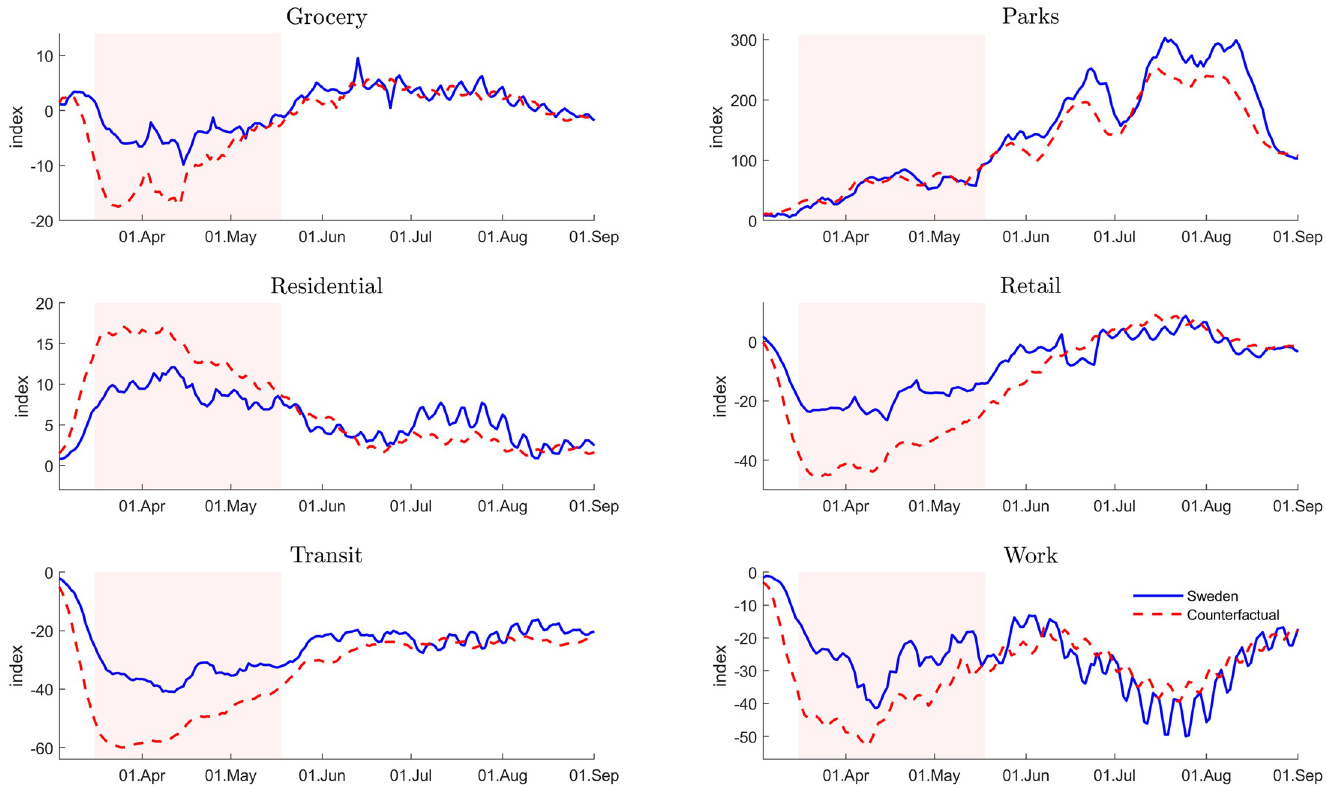
Fig 2. Mobility adjustment in Sweden. Actual outcome (blue solid line) vs control unit/counterfactual (red dashed line). Vertical axis measures percentage change relative to median in early 2020. Horizontal axis measures 11-day symmetric moving average. Pink shaded area indicates lockdown period. Construction of counterfactual: see Fig 1 (Specification A, Baseline). Data source: Google mobility reports [20].